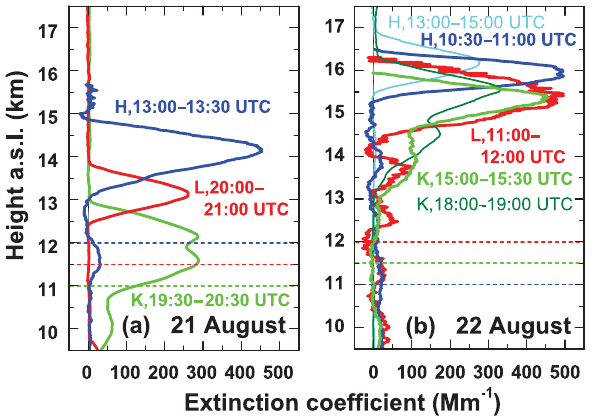
Figure 4. Height profile of the particle extinction coefficient at 532nm over Hohenpeissenberg (H), Leipzig (L), and Kosetice (K) on (a) 21 and (b) 22 August 2017. Time periods (in UTC) indi- cate signal averaging time periods. The Fernald method was applied to compute the extinction profiles. An input lidar ratio of 70sr (in agreement with nighttime Raman lidar observations of the smoke lidar ratio) was used. The uncertainty in the stratospheric extinction coefficients is estimated to be 15%. The horizontal dashed lines in- dicate the tropopause heights over the different lidar sites of Hohen- peissenberg (blue), Leipzig (red), and Kosetice (green) estimated from nearby radiosonde temperature and humidity profiles.